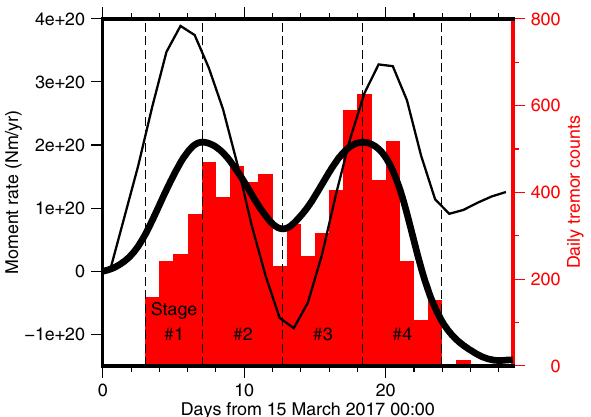
Figure 5. Moment rate history (solid curves) and daily tremor counts (red histogram). The thick and thin solid curves indicate moment rate history of 30-min and daily data inversions, respectively. The vertical broken lines indicate the boundaries of the four stages (Figs. 3, 4e and